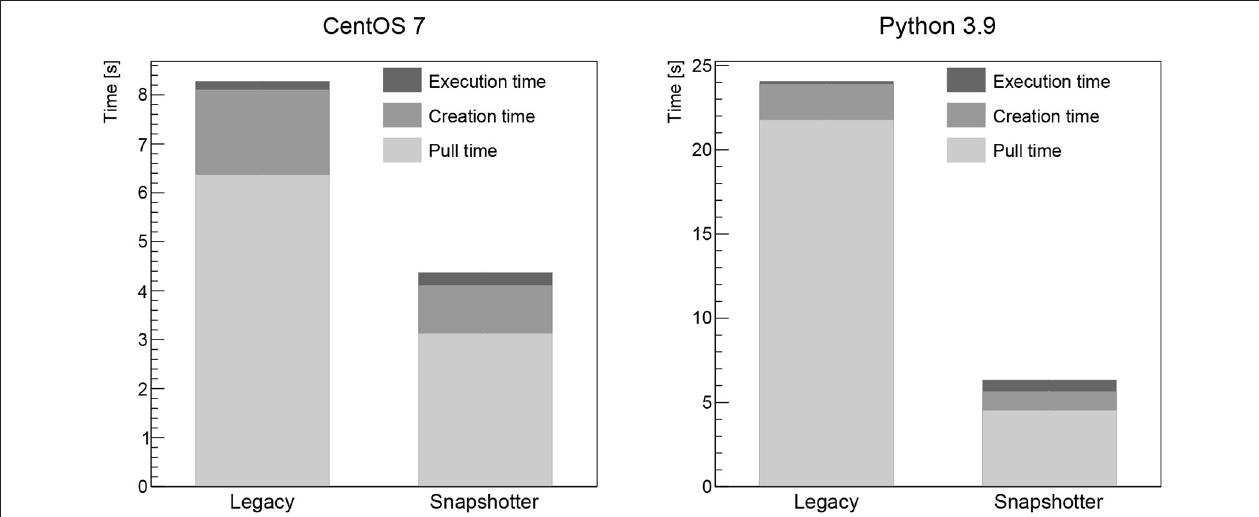
FIGURE 1 | Summary of the overall run time of the CentOS (Left) and Python (Right) workloads analyzed split into the container image pull time, the time to start the job after the container is ready as well as the time for the actual workload comparing the legacy and the snapshotter approaches.